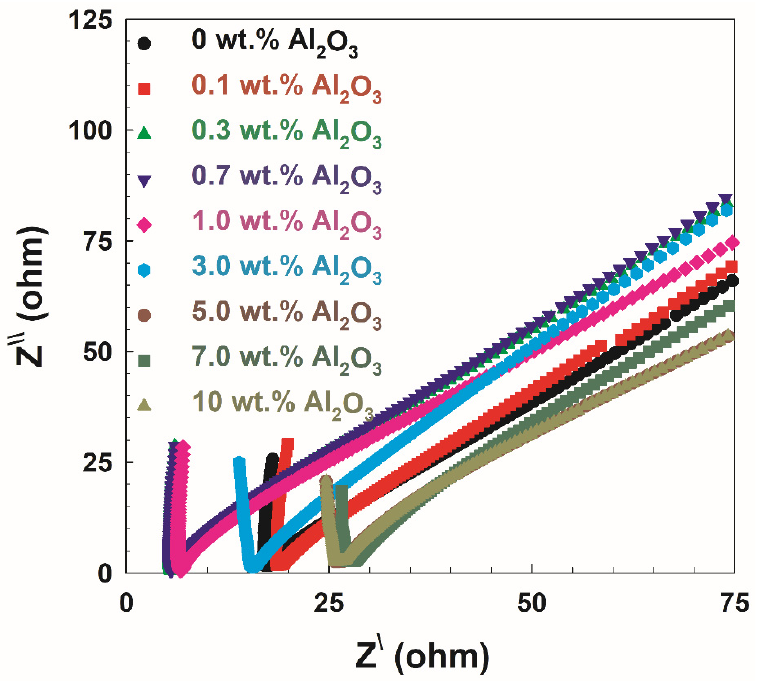
Figure 8. Cole–Cole plot for PVA/10 wt.% PEG/20 wt.% SSA membranes and different concentrations of Al 2 O 3 .